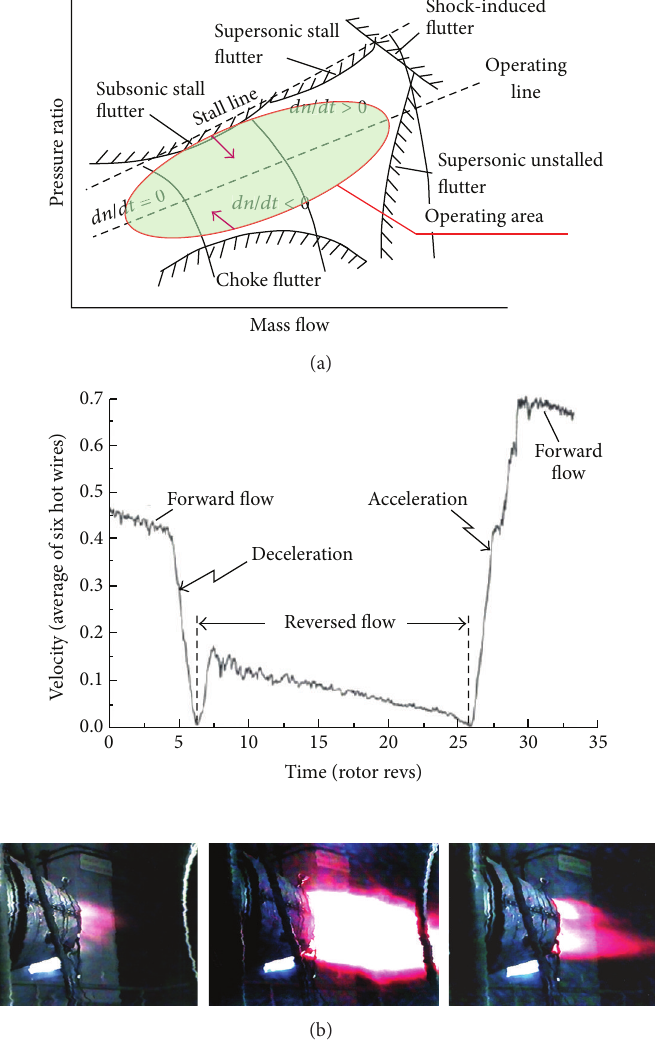
Figure 8: Showing (a) map of the compressor with information about dangerous threats [2, 3]; (b) deep surge cycle [3, 61]: the deceleration and acceleration of the flow in the compressor duct are a broadband impulse extortion for compressor blades and a bearing system (LCF concentrations) as well as with thermomechanical fatigue (TMF) for elements of a combustion chamber and the